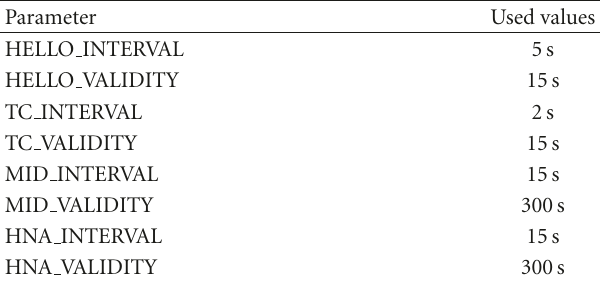
Table 3: OpenWRT parameters values for the OLSR protocol.